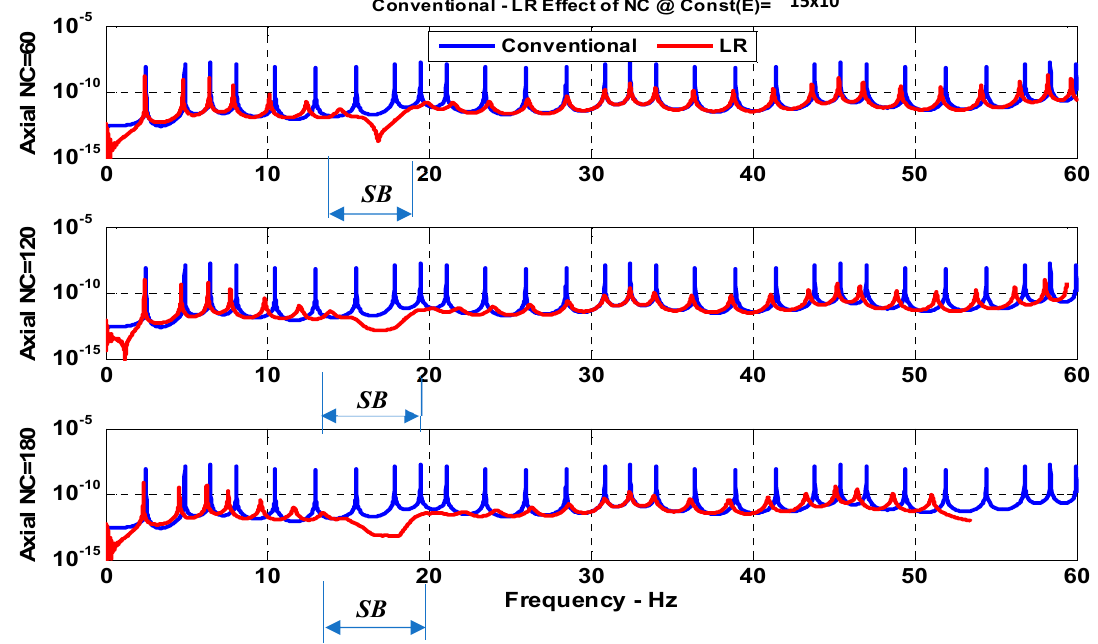
Figure 12. Comparisons between the axial frequency response characteristics of a conventional drill-string and a drill-string,